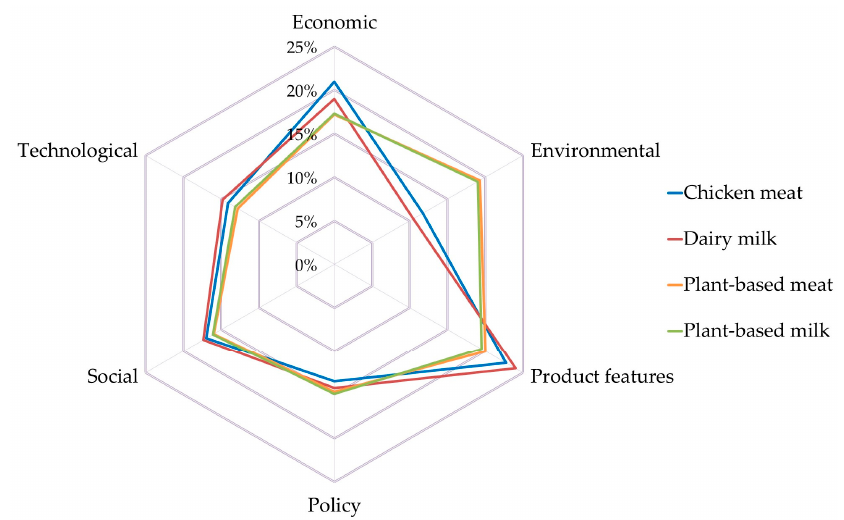
Figure 6. Overall performance of food products under each criterion (all stakeholder’ views). Average weight of each criterion (%).